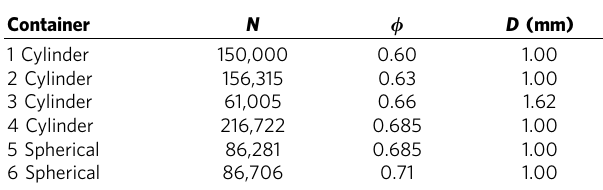
Table 1 | Summary of the experimental packings analysed in this